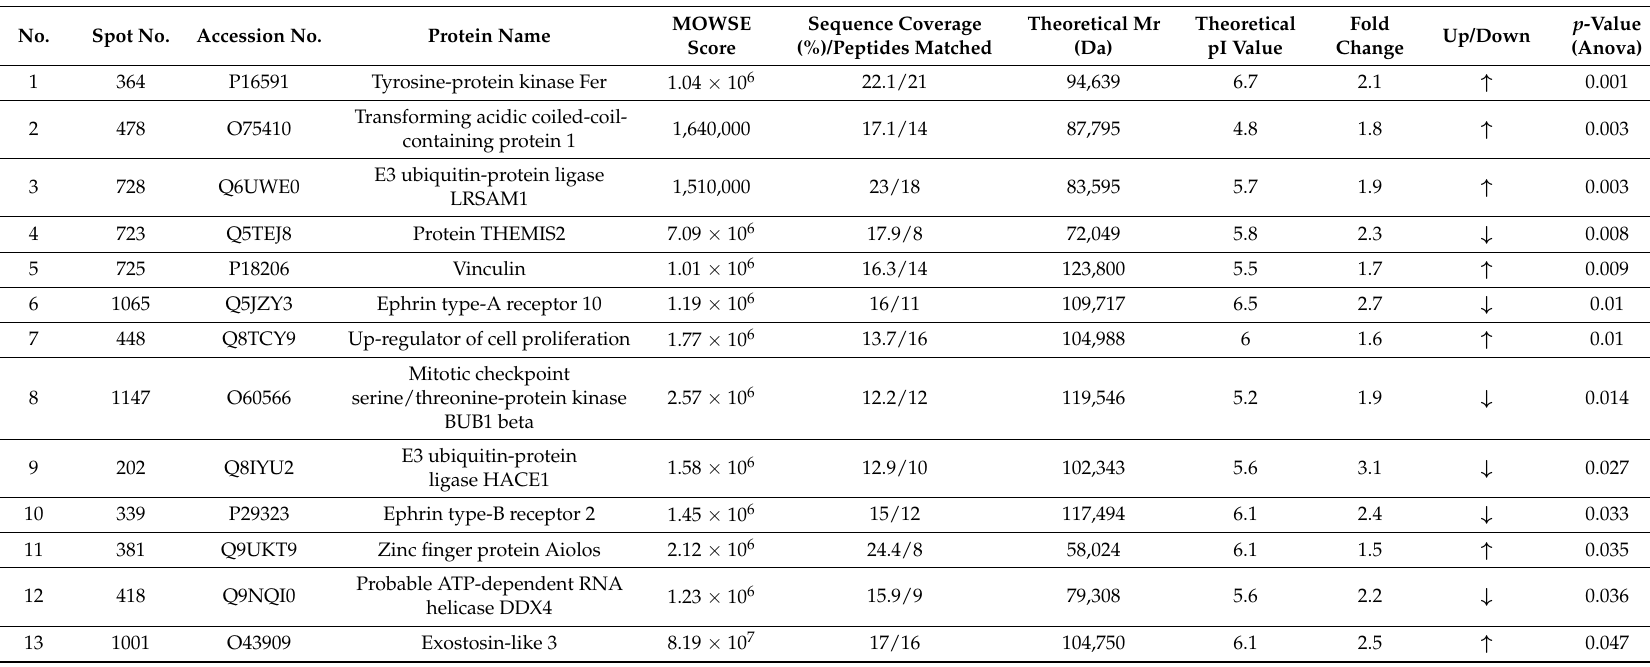
Table 1. List of differentially expressed proteins in AGS cells treated with PEC, identified using MALDI-TOF/TOF-MS analysis.